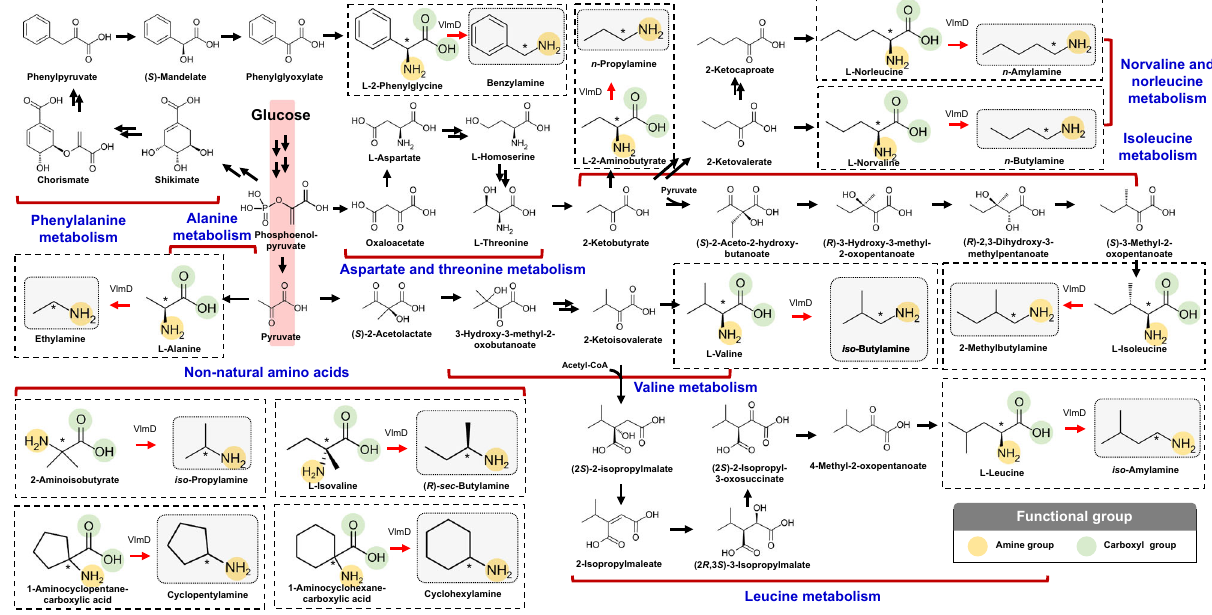
Fig. 4 Biosynthetic reactions constructed in E. coli for the in vivo production of 12 SCPAs. These 12 SCPAs were the ones shown to be produced by VlmD in vitro (dotted boxes). Amine and carboxylic groups shown in each dotted box are presented with yellow and green circles, respectively. Reaction center carbon atoms that are subject to chemical transformations are marked with asterisks. Glycolysis is indicated with a red background, which leads to the biosynthesis of 12 amino acid precursors. Multiple reactions are presented with two or more arrows.